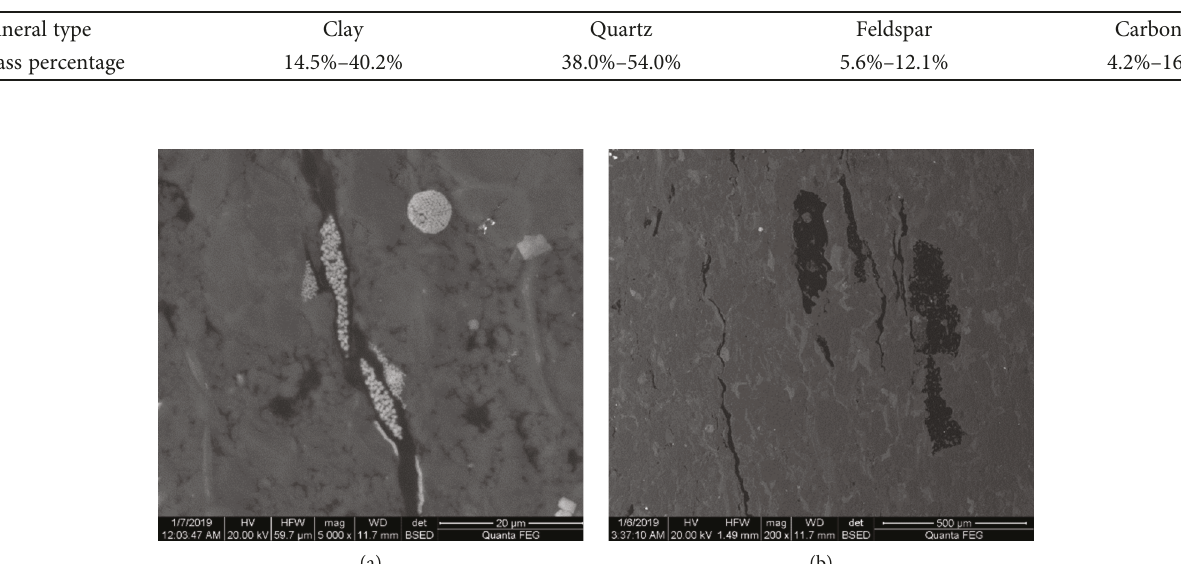
Figure 1: SEM images: (a) natural fracture fi lled with pyrite and (b) organic